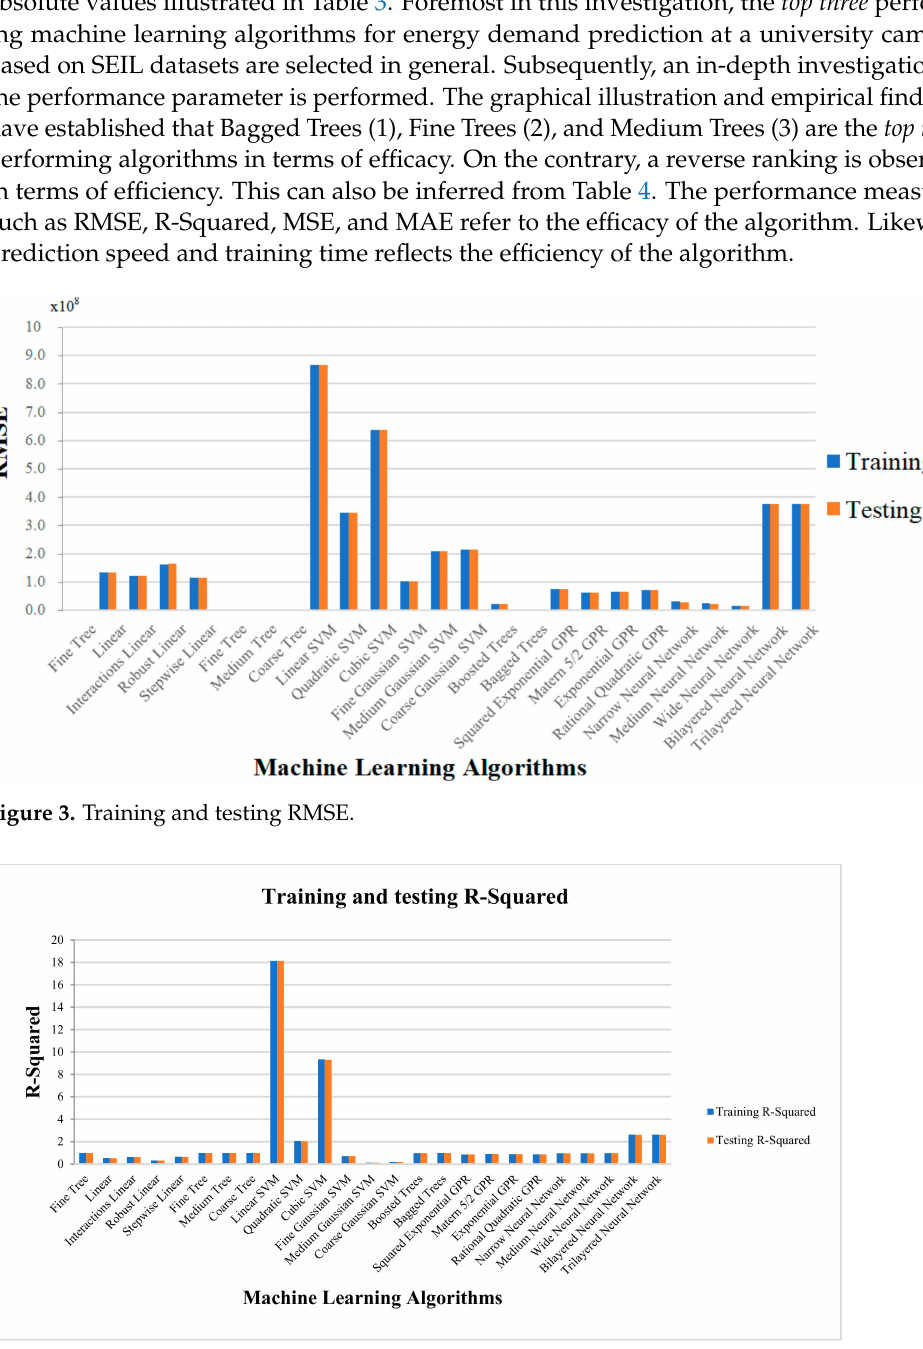
Figure 4. Training and testing